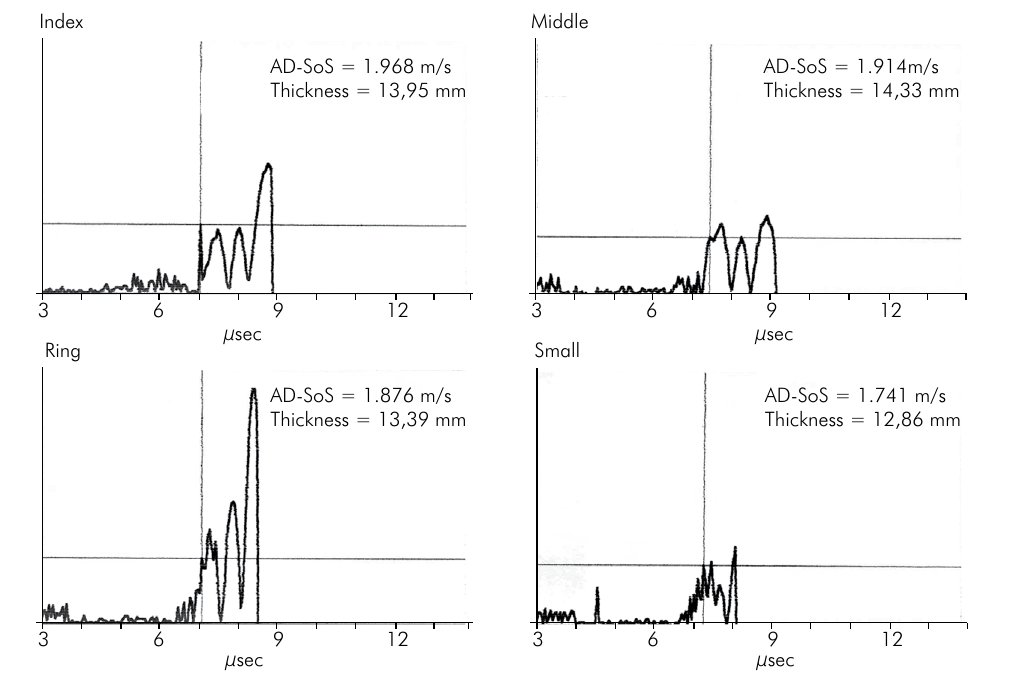
Figure 3. Biophysical bone profile of a BRONJ patient with frank bone exposure: attenuation of all pulses, high reduction of the number and inversion of the pulses. The first pulse represents long duration of total reabsorption. The value of AD-SoS < 1.949 m/s classifies the patient as having very low bone quantity; patient presents high risk of osteoporotic fractures.